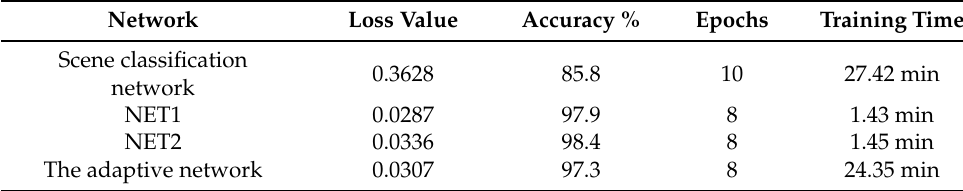
Table 2. Training information of pre-trained models.